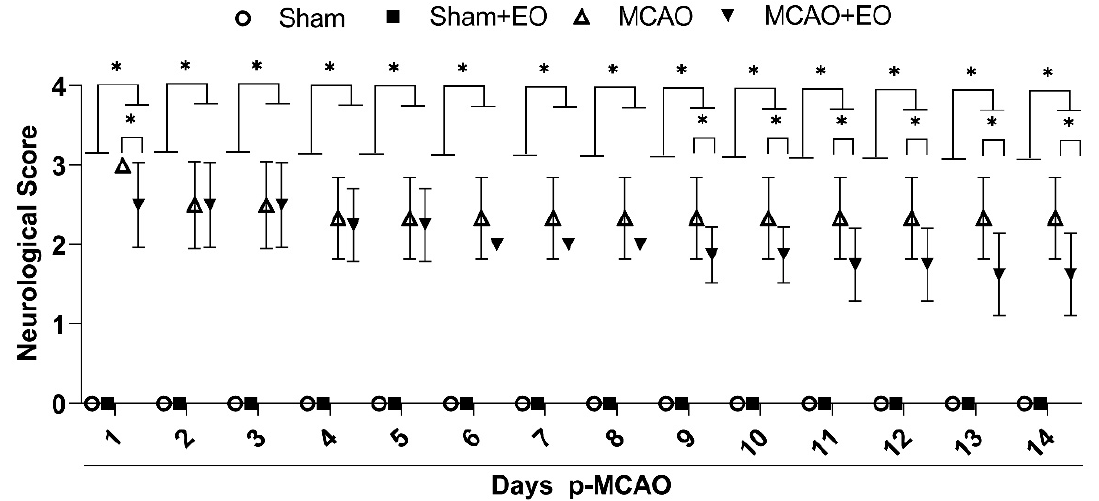
Figure 2. Neurological/motor deficit scores of the animals submitted to middle cerebral artery occlusion (MCAO) and treated with clarified Euterpe oleracea extract. The data are presented as